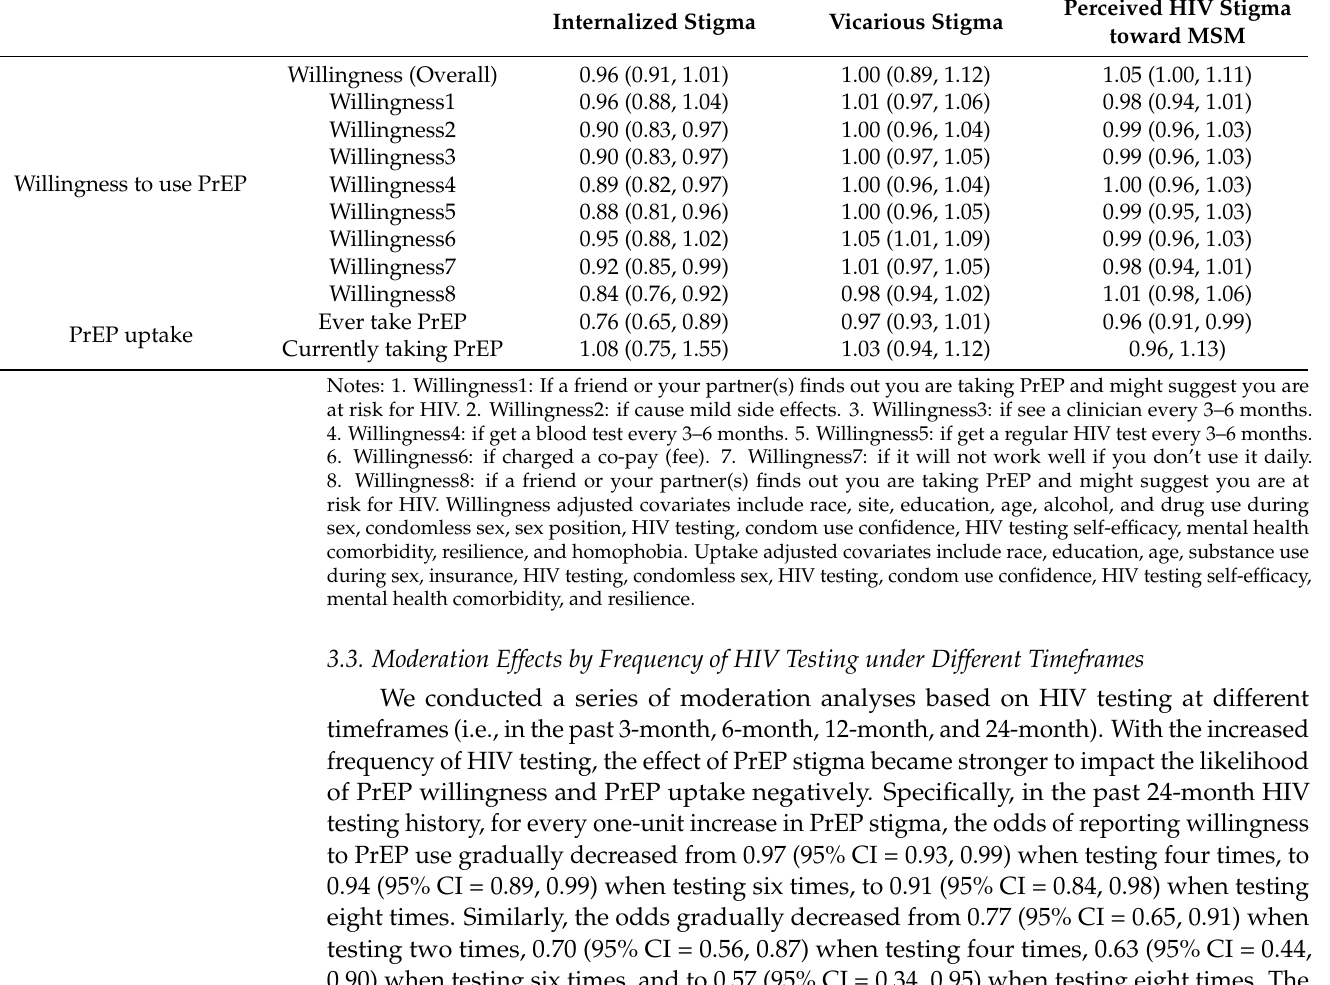
Table 3. Association between PrEP stigma and PrEP cascade (PrEP willingness, and PrEP uptake) among men who have sex with men ( n = 318). Internalized Stigma Vicarious Stigma